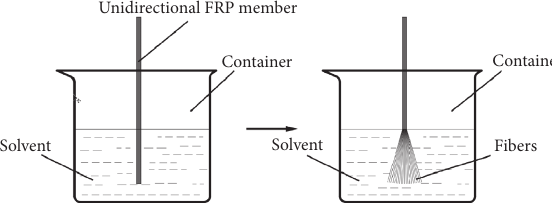
Figure 1: Dissolving the end of single unidirectional FRP member.